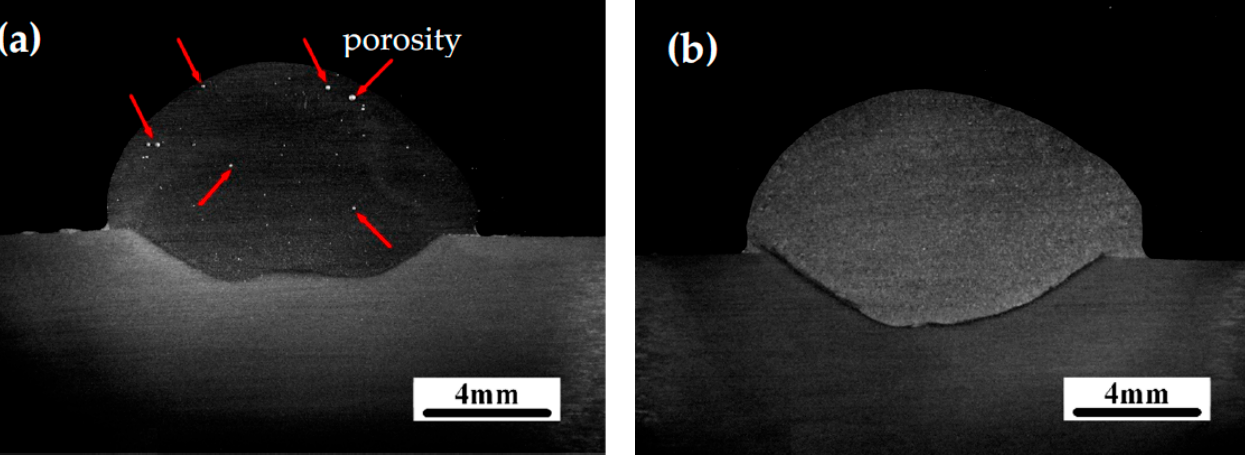
Figure 10. Comparison of weld morphology for ( a ) normal-pulse welding and ( b ) double-pulse welding ( f d = 3 Hz).